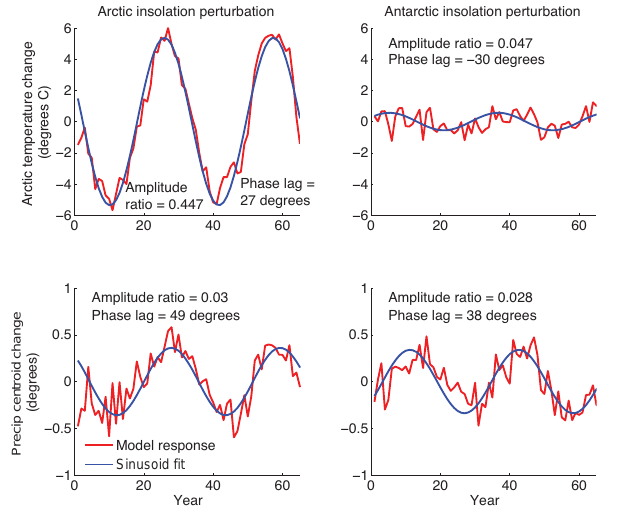
Figure 10. Results from the sinusoidal perturbations in the 2 × 2 design case. Input signal was u ( t ) = 0.12sin(0.2 t ), where 0.12 cor- responds to a maximum amplitude of 12% reduction or increase in solar irradiance in the region, and 0.2radyr − 1 is the chosen band- width (Sect. 3.3). Results are summarized in Eq.